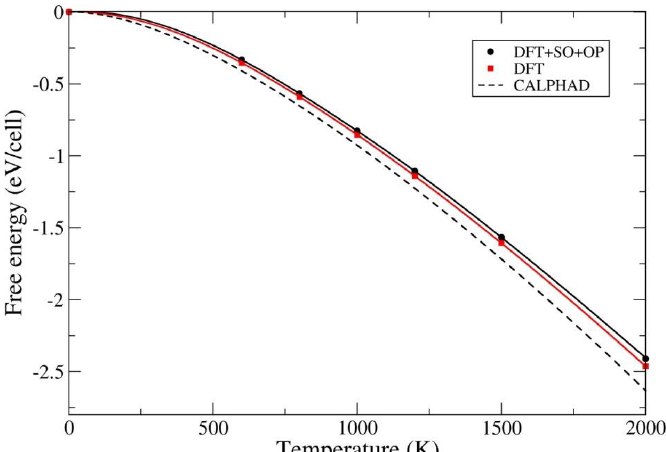
Figure 5. Free energies from SCAILD lattice contribution and electronic structure at volumes of 15.6 (DFT) and 16.2 Å 3 (DFT + SO + OP), respectively. The full lines are guides to the eye only. The dashed line shows the calculation of phase diagram (CALPHAD) Gibbs energy.